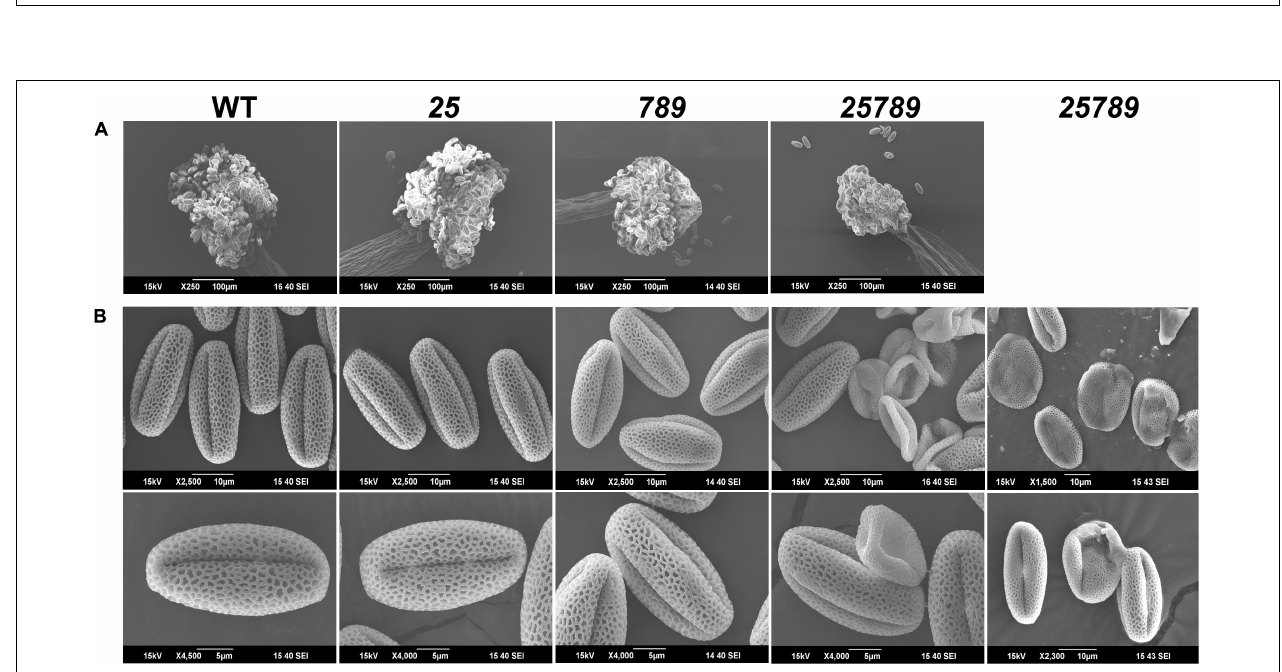
FIGURE 2 | Anther and pollen grains reveal defects in mature pollen grains of galt25789 Hyp-GALT mutants. (A) SEM images of anthers from WT, galt25 and galt789 and galt25789 showed that anther size is reduced in the galt25789 mutants. (B) SEM images of the WT, galt25, galt789 and galt25789 pollen grains. Galt25789 mutant displayed misshaped, collapsed, and defective pollen with abnormal exine patterns in comparison to regular reticulate exine structure in WT. Scale bars = 100 µ m in (A) , 10 and 5 µ m in (B) as indicated.